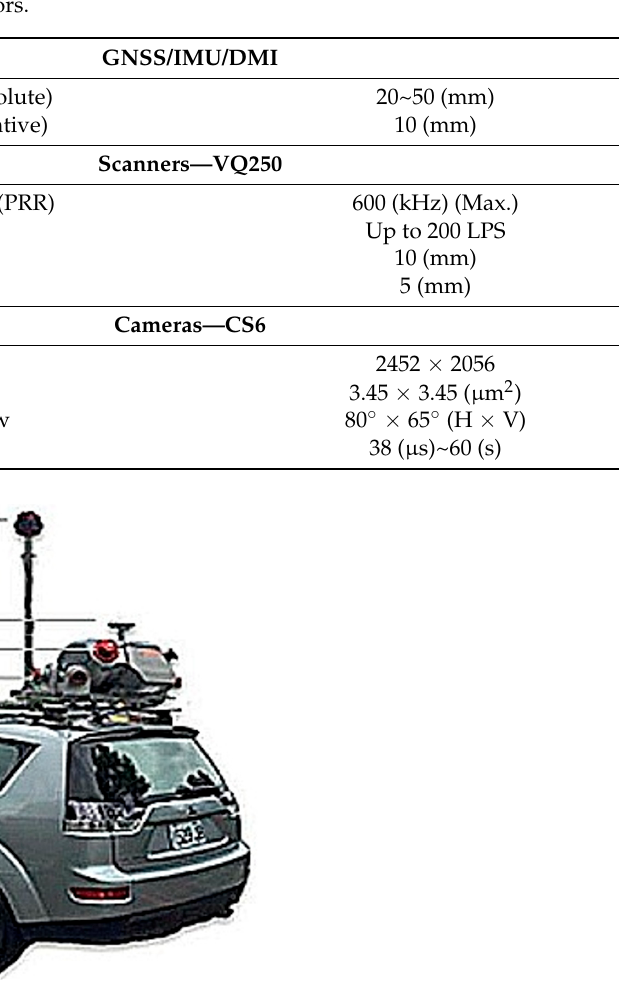
11 Figure 8. Satellite image of the Taiwan CAR Lab (from Google Maps). The parts marked in red are the road sections that were chosen for testing to generate data. “A” is a corner section, and the other parts are straight roads with different numbers and directions of lanes. The non-English fonts are